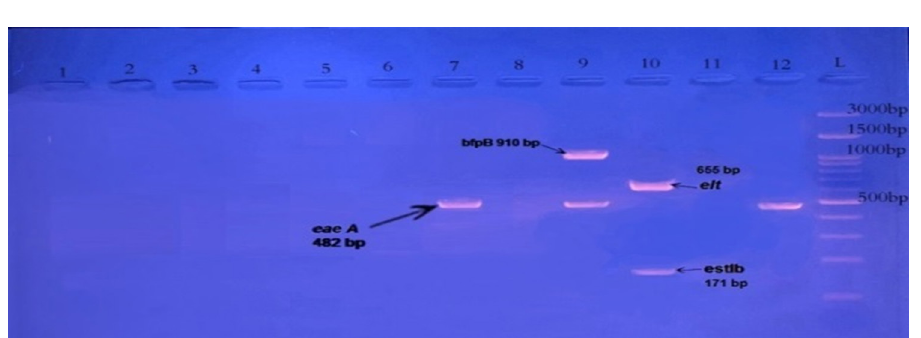
Fig. 8. Gel electrophoresis of amplified (eaeA, bfpB, aggR, astA, pic, hly, stx1, stx2, invE, ipaH, elt, estIa ,estIb) genes, the product size (482, 910, 400, 102, 1, 111, 688, 244, 324, 766, 437, 655, 157, 171 (bp) respectively), of E. coli strains using conventional PCR. Agarose 2%, and TBE (1X ) at (75 V/cm for 90 min., stained with Ethidium bromide dye and visualized on a UV transilluminator. Lane (L): DNA ladder (100-3000bp), Lanes: (1-12 ) stool